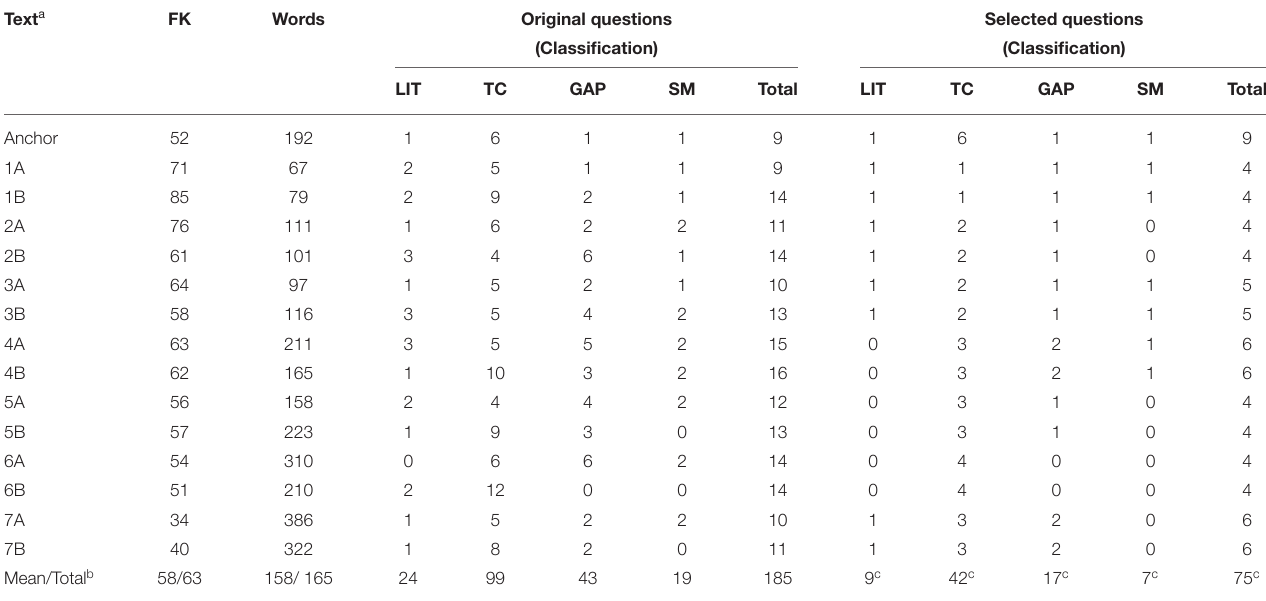
TABLE 2 | Characterization of the texts and its questions (anchor, Form A, and Form B) before and after item selection. Text a FK Words Original questions